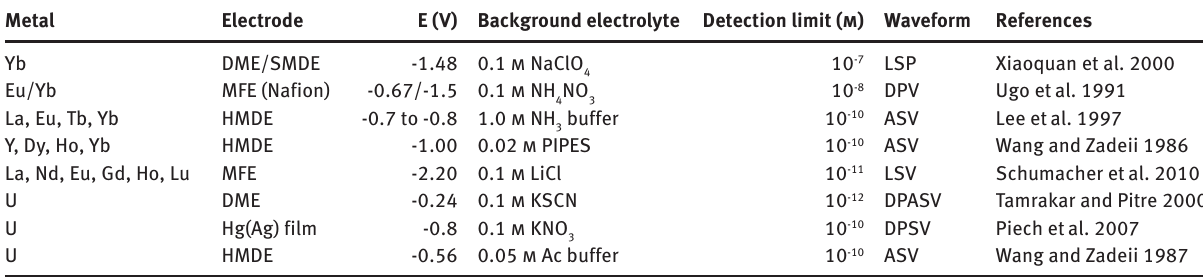
Table 4 Summary of electrochemical data of Ln and An on mercury films.